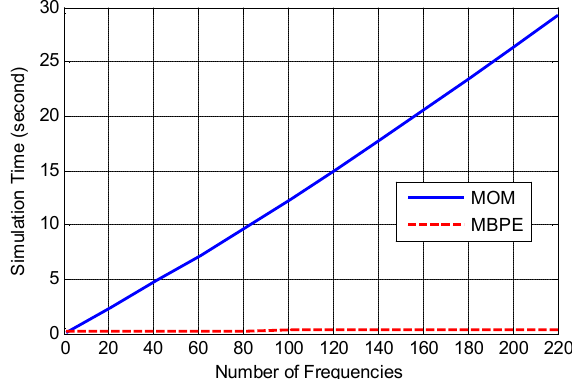
Figure 4: The consumed computation time of MBPE technique and MOM simulation when increasing the number of frequencies. Fig. 5 show the current distributions on the antenna at f = 0.4 f 0 and f = 1.6 f 0 when the length of the thin-wire antenna L is 1m. The comparison between the solid curves computed using MOM and the dashed curves computed using MBPE technique shows that good agreement is achieved. It can be seen from Fig. 5 that MBPE technique taking 9 derivatives ( n = 5, d = 4) provides accurate results using the solution obtained by MOM at f 0 . The normalized maximum error over the frequency band is shown Fig.